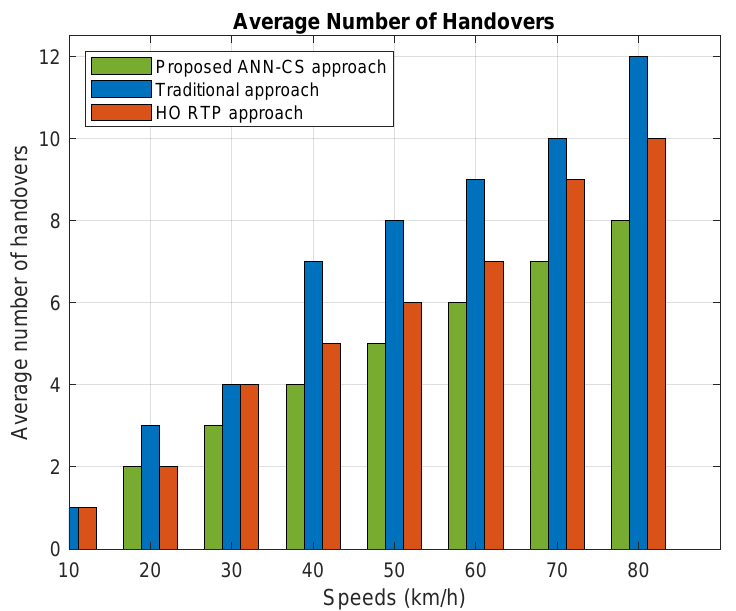
Figure 10. Average number of HOs.